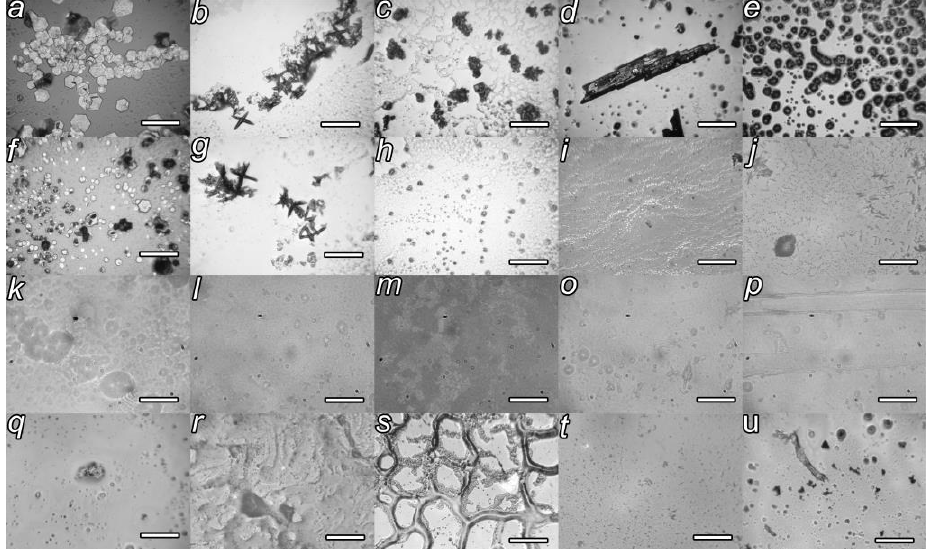
Fig. 1. Microphotographs of fullerene (a - CCl 4 1 ml; b - CH 2 Cl 2 1 ml; c - CHCl 3 1 ml; d - C 6 H 6 1 ml; e - C 6 H 5 CH 3 1 ml; f - CCl 4 0.15 ml; g - CH 2 Cl 2 0.15 ml; h - CHCl 3 0.15 ml; I - C 6 H 6 0.15 ml; j - C 6 H 5 CH 3 0.15 ml) and FCM (k - CCl 4 1 ml; l - CH 2 Cl 2 1 ml; m - CHCl 3 1 ml; o - C 6 H 6 1 ml; p - C